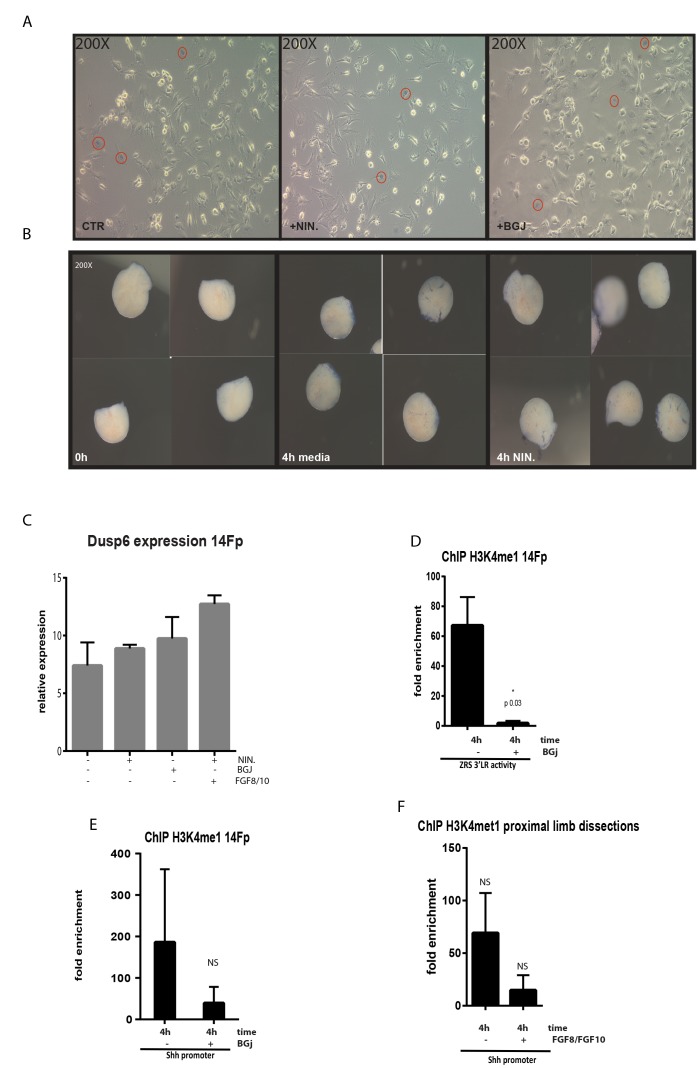
Analysis of 14Fp and limb bud cultures after treatment with the NIN and BJG inhibitors.(A) Cell morphology of 14Fp was assessed after nintedanib (NIN) and BGJ398 (BGJ) treatments by microscopy. Cells were stained with 1× trypan blue and the number of blue nuclei assessed (red circles). No differences were observed between the different treatments and the control. (B) Trypan blue staining was performed on limb tissue dissected following a treatment of 4 hr with NIN and analysed by microscopy. Represented are time 0, 4 hr media alone or 4 hr with NIN. No differences were observed between the media alone or NIN treatment. (C) Quantitative reverse transcriptase (qRT)-PCR to detect the expression of Dusp6 after 4 hr of NIN, with or without supplement of FGF8/10 for 6 hr, and BGJ treatment. Data points represent the average of duplicate determinations ± SEM. (D) Chromatin from 14Fp was harvested after BGJ treatments and chromatin immunoprecipitation (ChIP) for H3K4me1 was carried out. DNA was quantified by q-PCR using the ZRS 3’ long range (3’LR) (D) and Shh promoter oligos (E) as control. Data are represented as mean ± SEM of the fold enrichment over nonspecific IgG recoveries from two independent experiments. (F) H3K4me1 ChIP of the proximal mesenchyme of embryonic day 11.5 (E11.5) limb buds after 6 hr of exposure to FGF8 and FGF10. Fold enrichment over nonspecific IgG recoveries and ± SEM from two independent experiments are plotted. DNA was quantified by q-PCR using Shh promoter oligos.